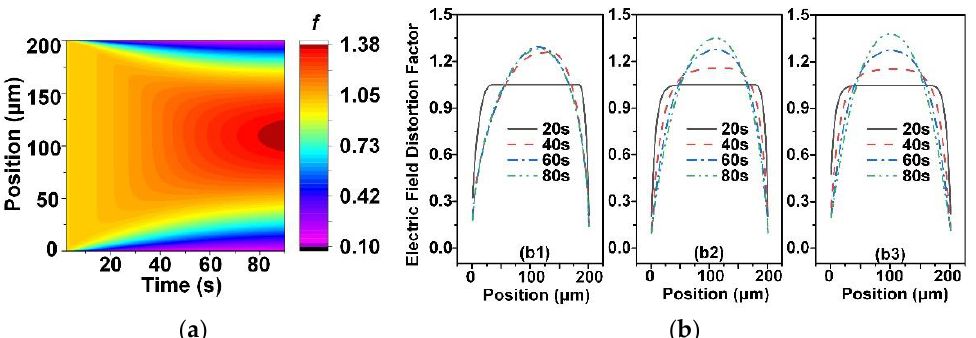
Figure 6. Electric field distribution factor in the sample with random orientation ( a ) and comparisons of electric field distribution factor as a function of position in the polymer with various orientations ( b ): parallel orientation ( b1 ) random orientation ( b2 ) perpendicular orientation ( b3 ).